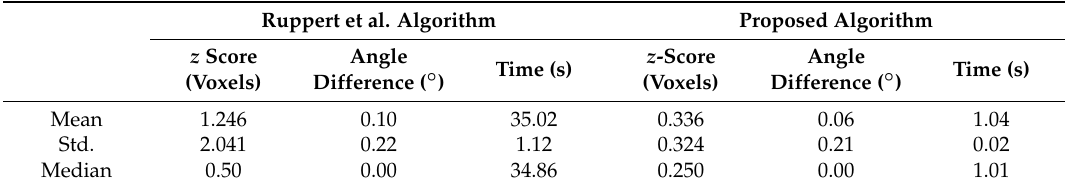
Table 2. Quantitative results comparison for perfectly symmetric datasets. Ruppert et al. Algorithm Proposed